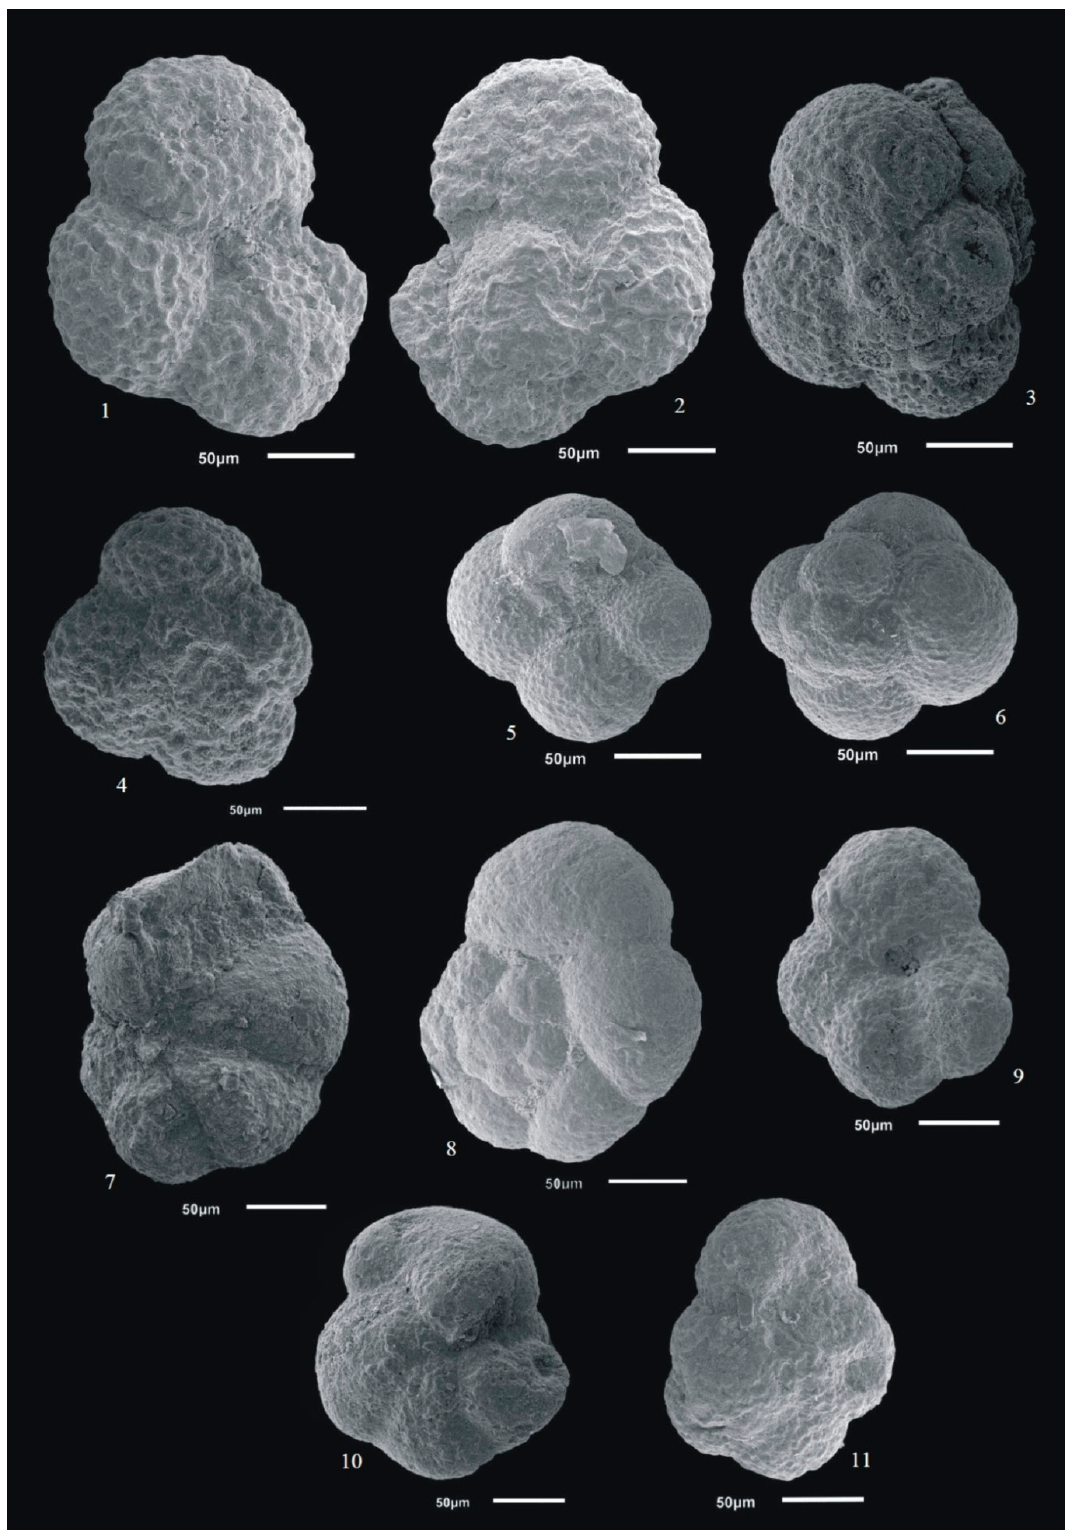
Figure 3. Planktonic foraminifera identified in the gypsum sample (SEM pictures): (1–4). Globigerina bulloides d’Orbigny; (5,6). Globigerina bollii Cita & Premoli-Silva; (7,8). Globorotalia transsylvanica Popescu; Paragoborotalia sp .; (9,11). Tenuitella angustiumbilicata (Bolii); (10). Globorotalia praescitula Blow.